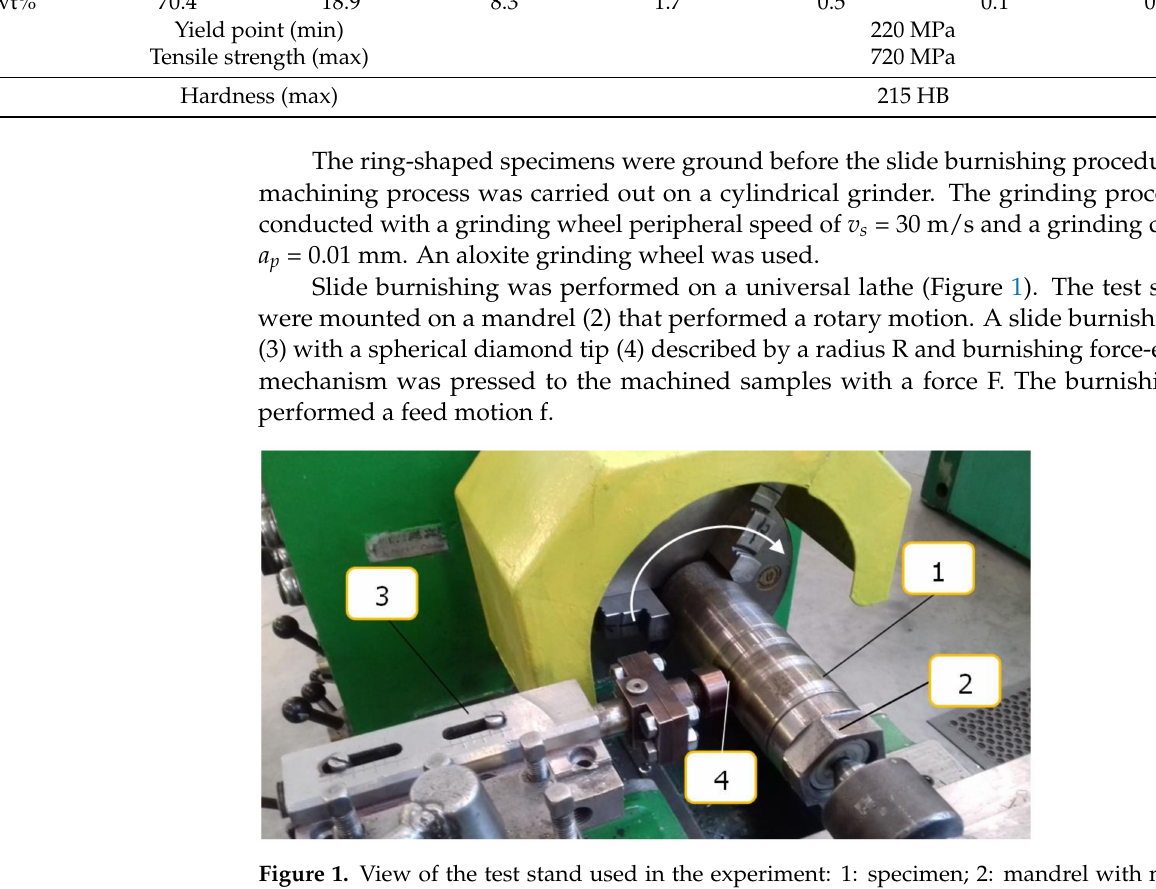
Figure 1. View of the test stand used in the experiment: 1: specimen; 2: mandrel with mounted samples; 3: slide burnishing tool; 4: diamond tip with radius R.